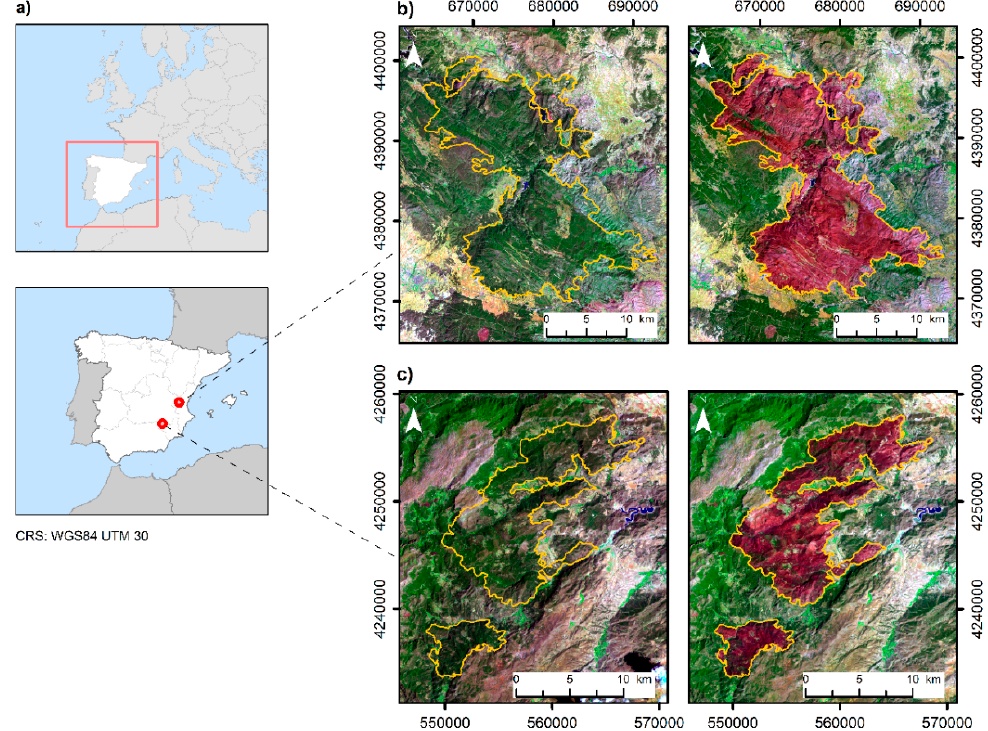
Figure 1. Study areas located in the Iberian Peninsula: Requena above, Yeste below; ( a ) location of the study areas; ( b ) pre- and post-fire Landsat composition for Requena RGB (SWIR2, NIR, Blue) and ( c ) pre- and post-fire Landsat composition for Yeste RGB (SWIR2, NIR,